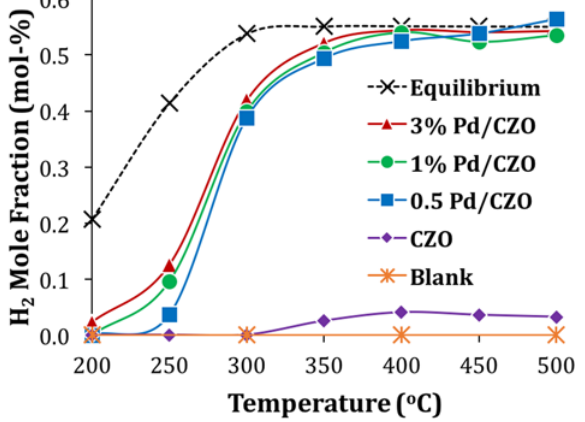
Figure 5. Activity of fresh Pd/CZO catalysts with different metal loadings (0%, 0.5%, 1%, and 3%) in converting simulated engine exhaust gas at fuel rich condition. Catalyst activity is plotted in terms of H 2 product mole fraction as a function of reaction temperature (200 °C to 550 °C). Reaction feed: 500 ppm propane, 10% H 2 O, and N 2 balance, with total GHSV of 30,000 h − 1